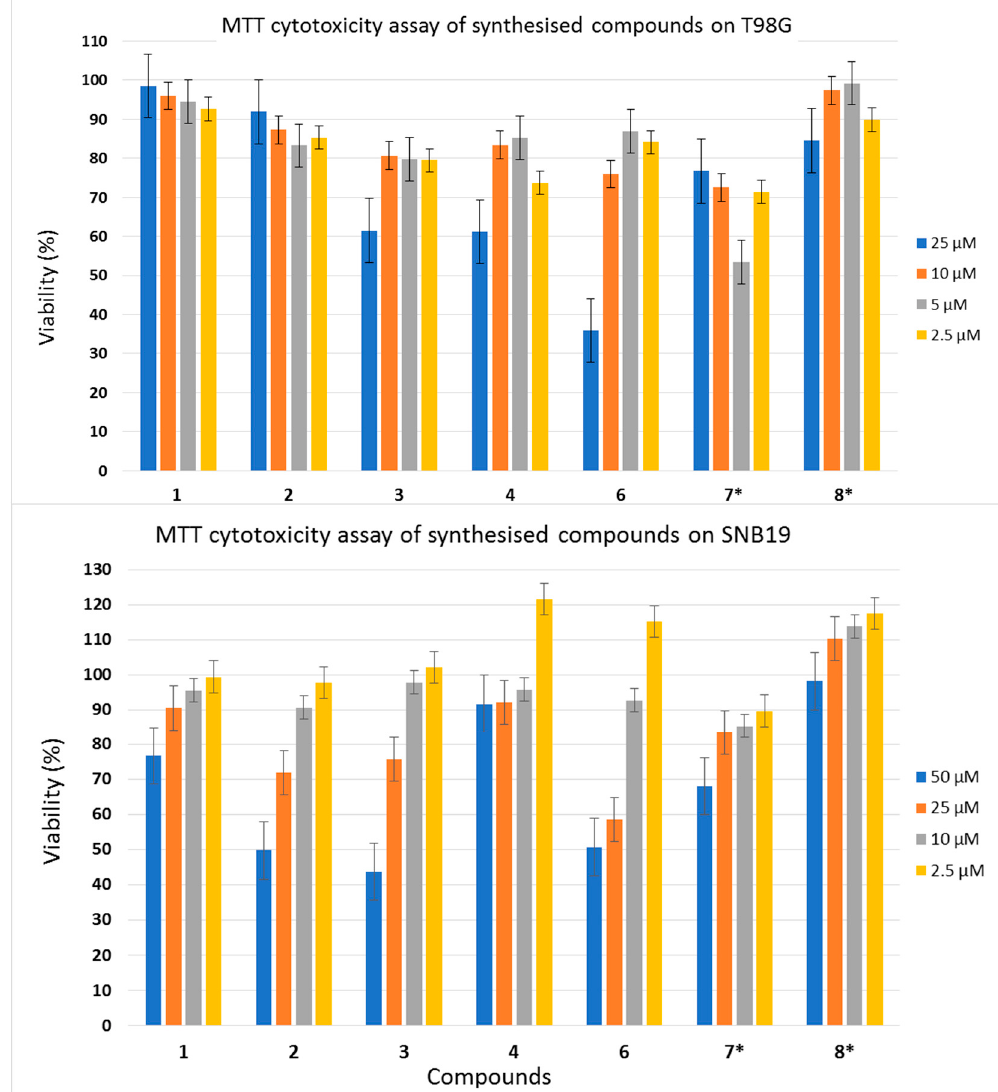
Figure 4. Individual cytotoxicity of studied compounds in the T98G and SNB19 glioma cell lines. * Compounds 7 and 8 formed visible micelles when stock solutions were dissolved in a cell growth medium, as shown by light microscopy. The cytotoxicity of these compounds was studied; however, the concentrations of their solutions may be significantly different from those indicated in dilutions.